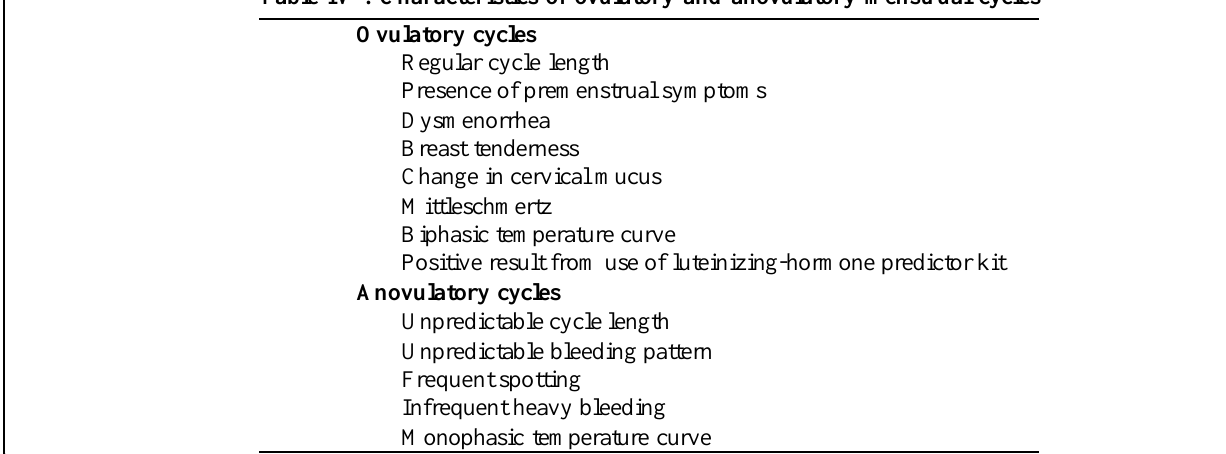
Table IV : Characteristics of ovulatory and anovulatory menstrual cycles Ovulatory